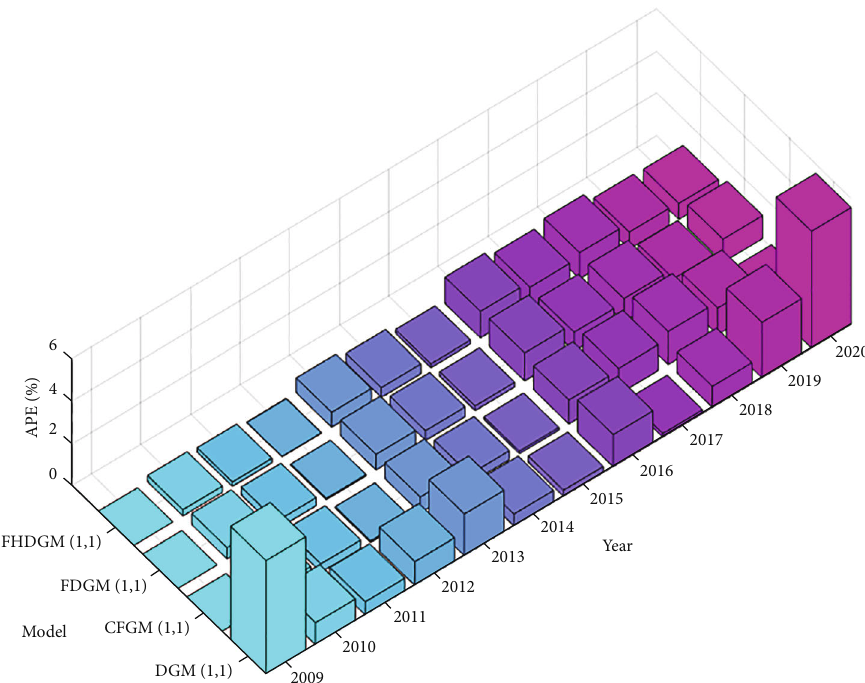
Figure 11: APE of renewable energy consumption prediction in the